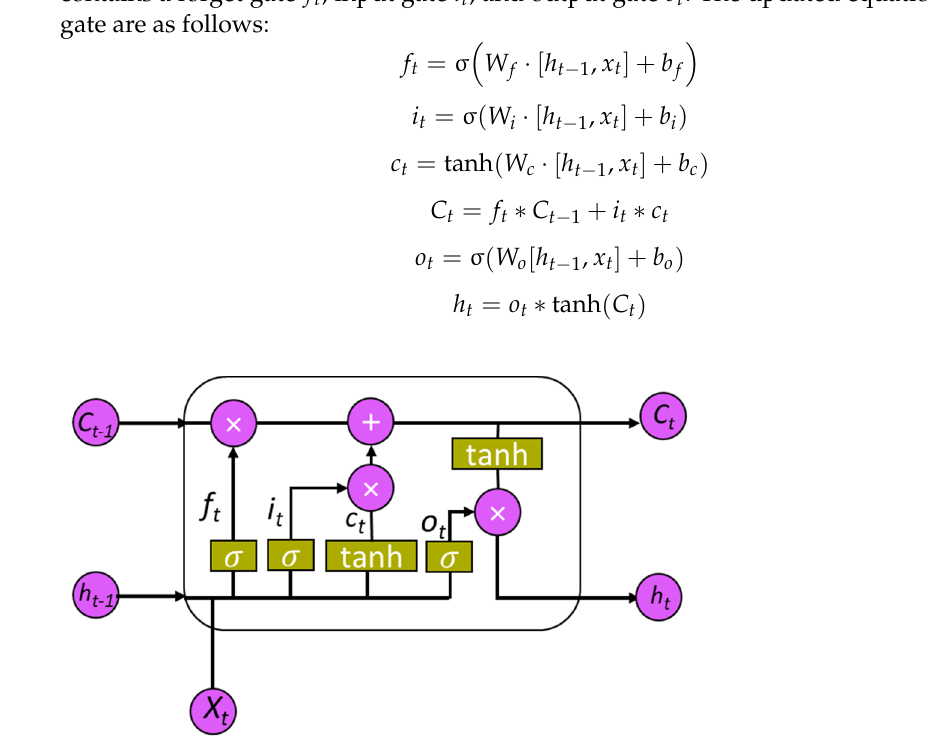
Figure 4. Structure of an LSTM